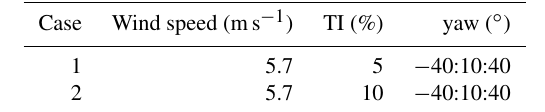
Table 5. CL-Windcon single-turbine experiment